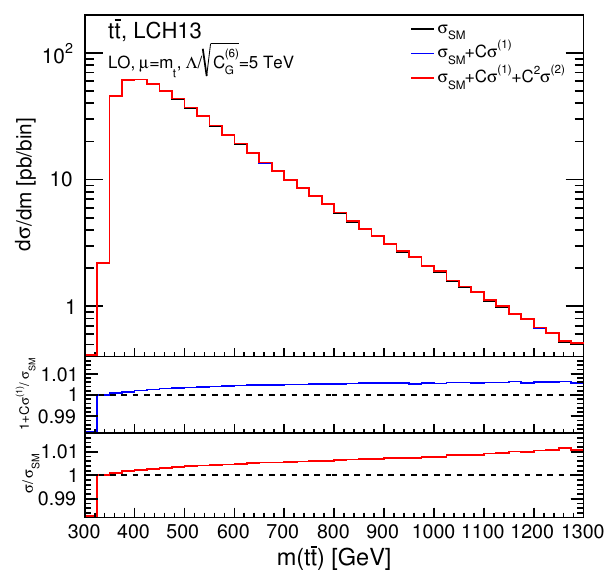
Figure 9 . Invariant mass of a pair of top quarks produced at LHC13, for the SM and including at most one insertion of the O G operator in the production amplitudes ( O (1 = (cid:3) 2 ) and O (1 = (cid:3) 4 )